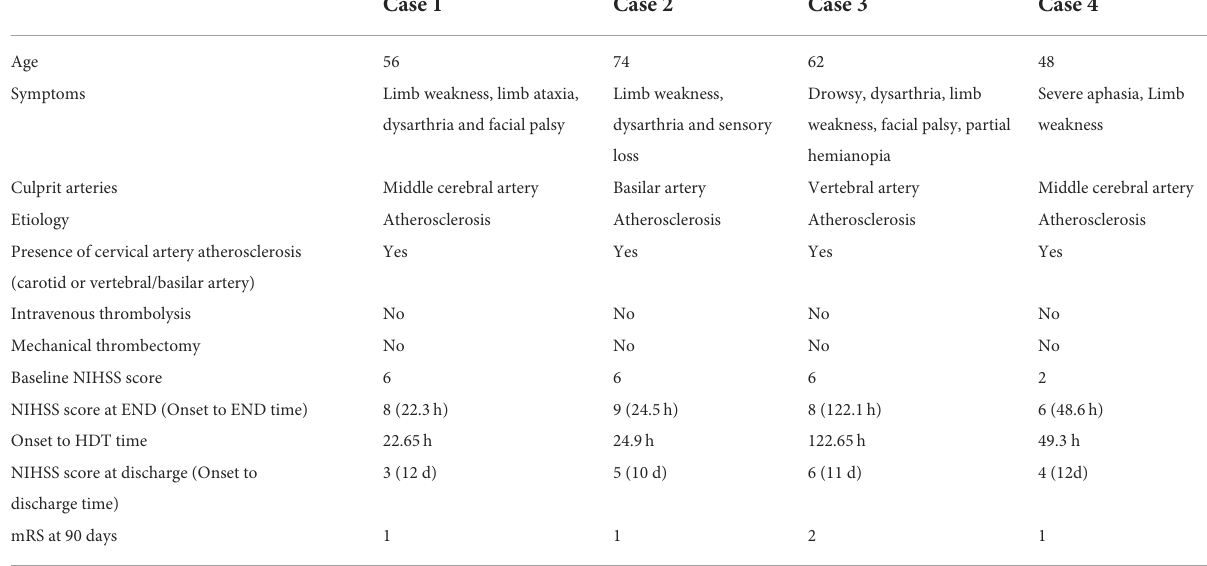
TABLE 1 Characteristics of patients.